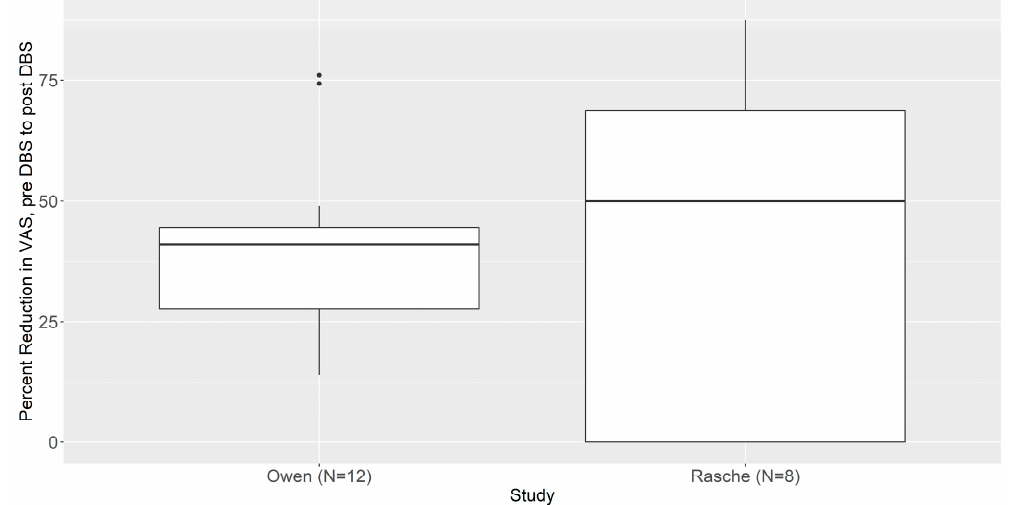
Figure 4. The percentage change in pain scores pre- and post-DBS at 3 months follow-up for the included studies. The boxplot shows the median, the upper and lower quartiles, and the two whiskers. The upper whisker extends from the upper quartile to the largest value no further than 1.5 × IQR from the upper quartile, where IQR is the inter-quartile range, or distance between the upper and lower quartiles. The lower whisker has an analogous definition (this is Tukey’s definition of a Boxplot).